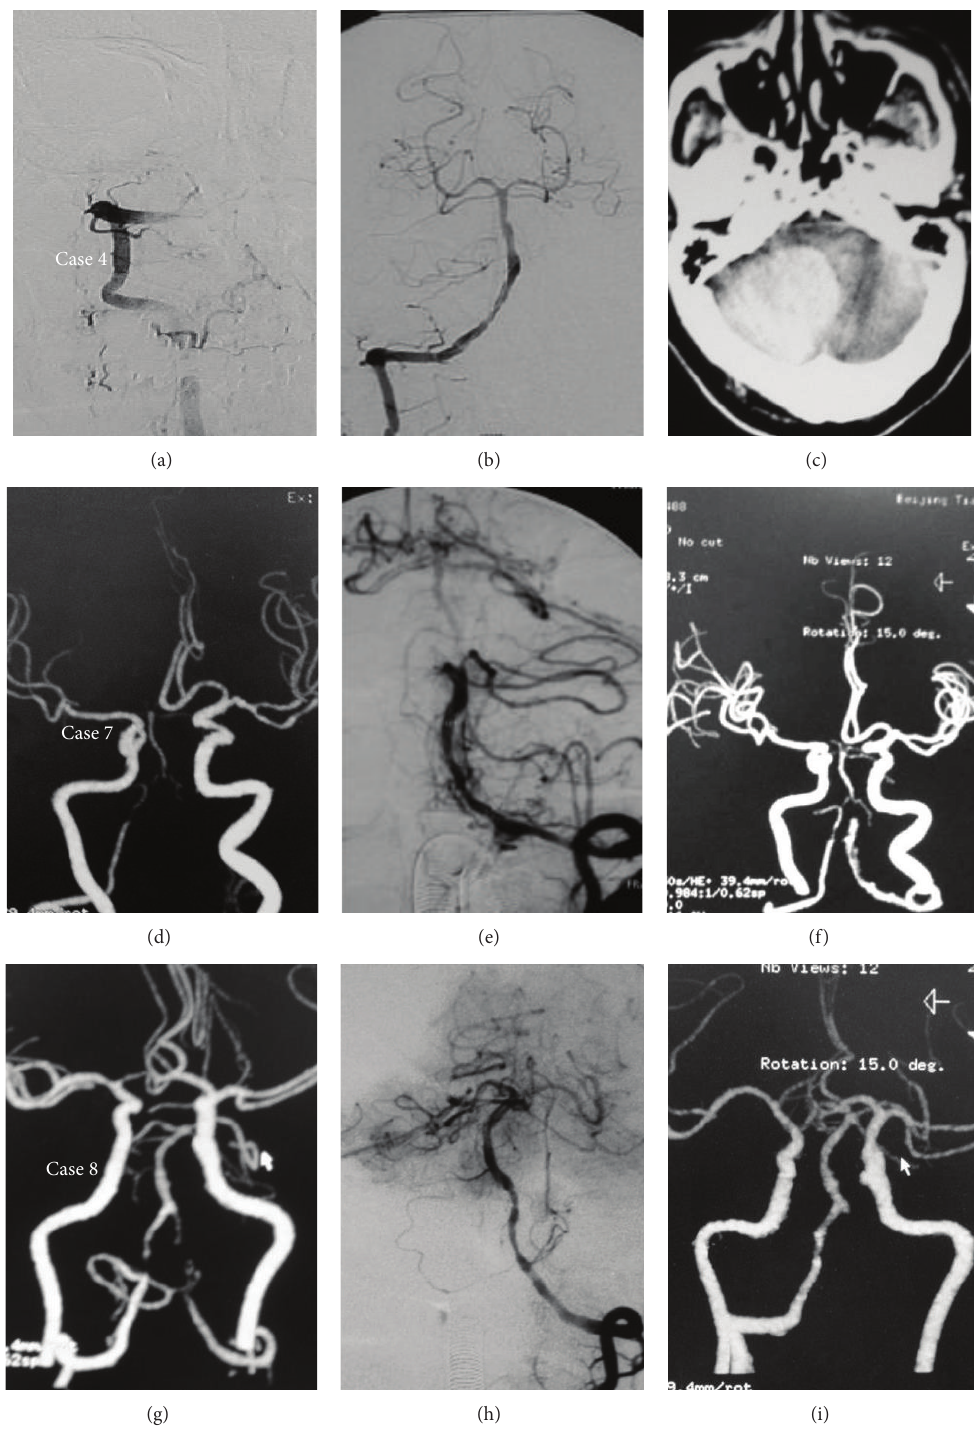
Figure 3: A 61-year-old man (case 4) with bilateral intracranial vertebral artery (ICVA) total occlusion (a). Following stenting of right ICVA (b), cerebellum hemorrhage due to perforation was found on the postprocedure CT (c). A 71-year-old man (case 7) with the left ICVA total occlusion and the right ICVA severe stenosis (d). D asymptomatic distal dissection and proximal perforation adjacent to the occlusion occurred during the procedure (e). The perforation resolved after balloon occlusion (f). A 37-year-old man (case 8) with the left ICVA total occlusion and the right ICVA severe stenosis (g). Both ICVA were recanalized but in-stent thrombosis occurred on the left ICVA as shown on day 1 after procedure CTA ((h),